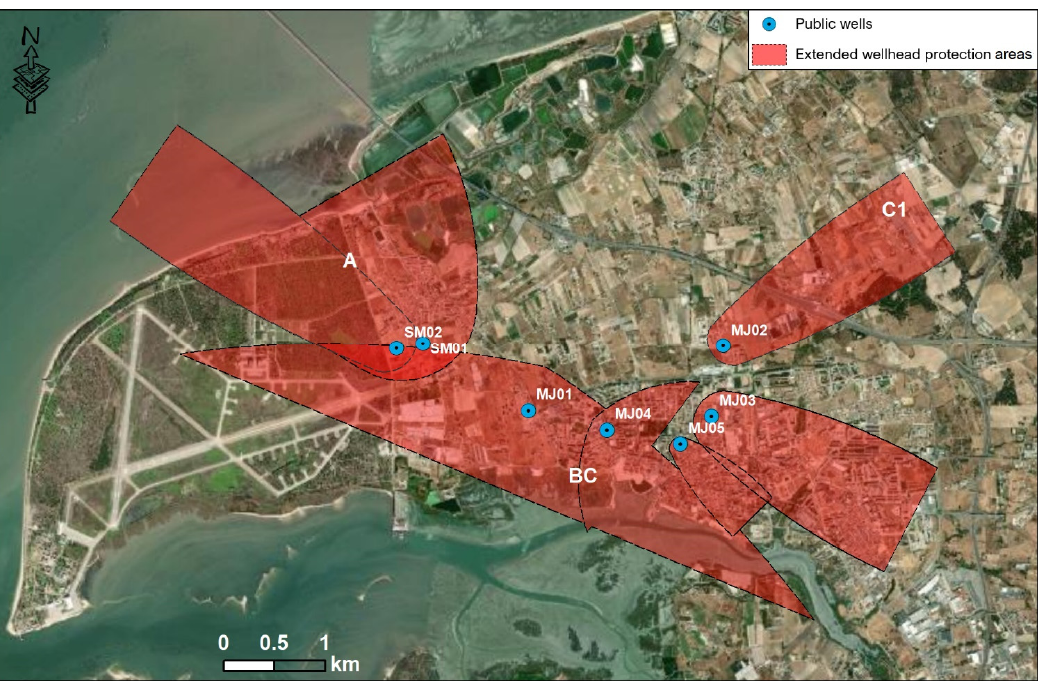
Figure 11. Extended wellhead protection zones delimited by the Jacob and Bear method.